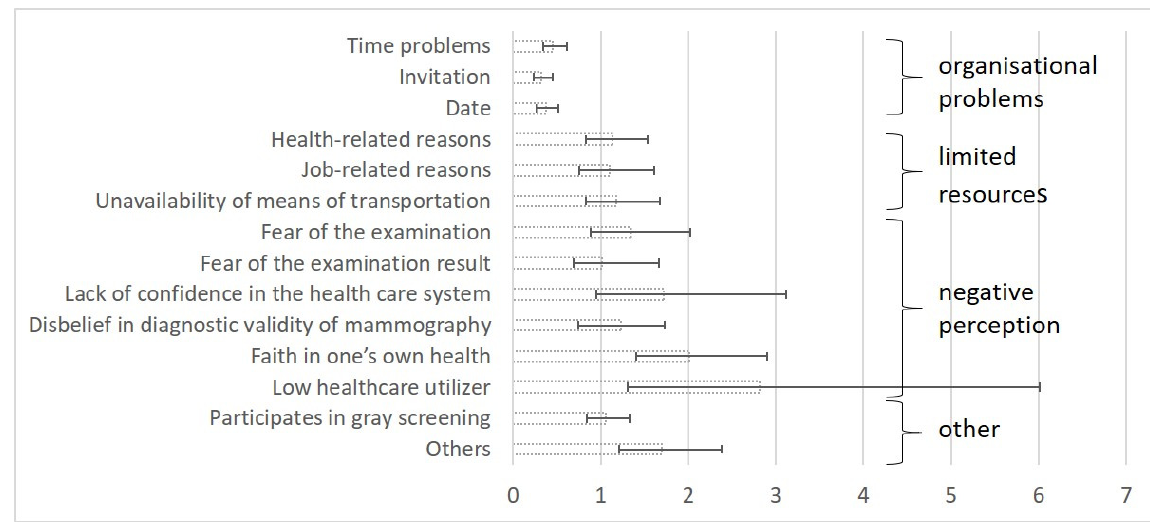
Figure 3. Odds ‐ ratios for participation. Figure 3. Odds-ratios for